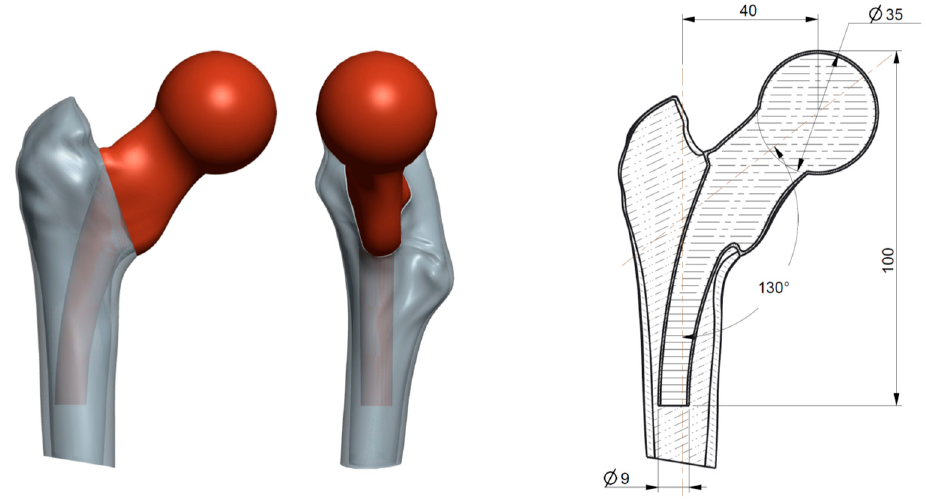
Figure 9. Designed assembly of a femoral bone with a hip replacement.